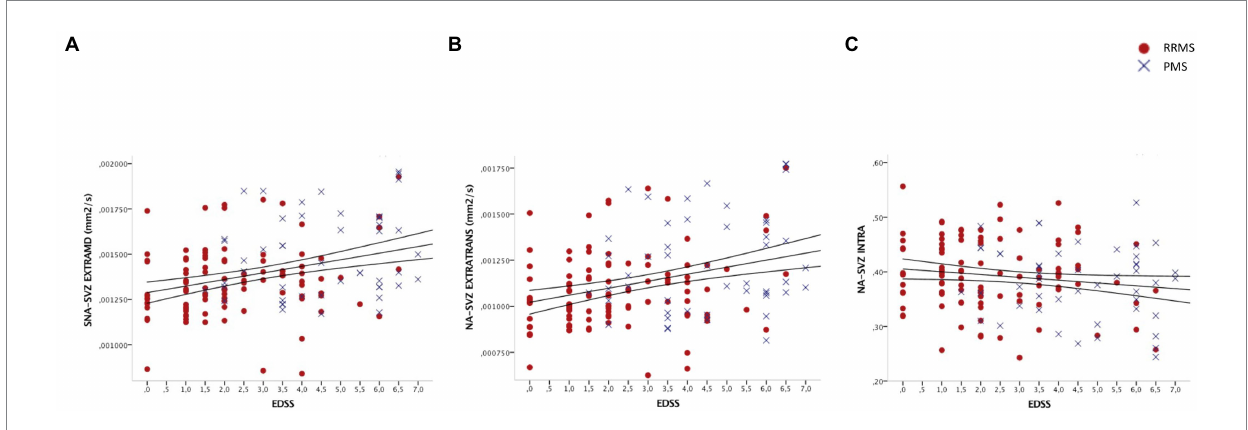
FIGURE 2 Scatter plot showing associations between (A) EXTRATRAMD of the NA-SVZ and EDSS; (B) EXTRATRANS of the NA-SVZ and EDSS; and (C) INTRA of the NA-SVZ and EDSS. EDSS = expanded disability status scale; RRMS = relapsing–remitting multiple sclerosis; PMS = progressive multiple sclerosis; NA- SVZ = normal appearing sub-ventricular zone Axes represent residuals. Linear fit and 95% confidence intervals are